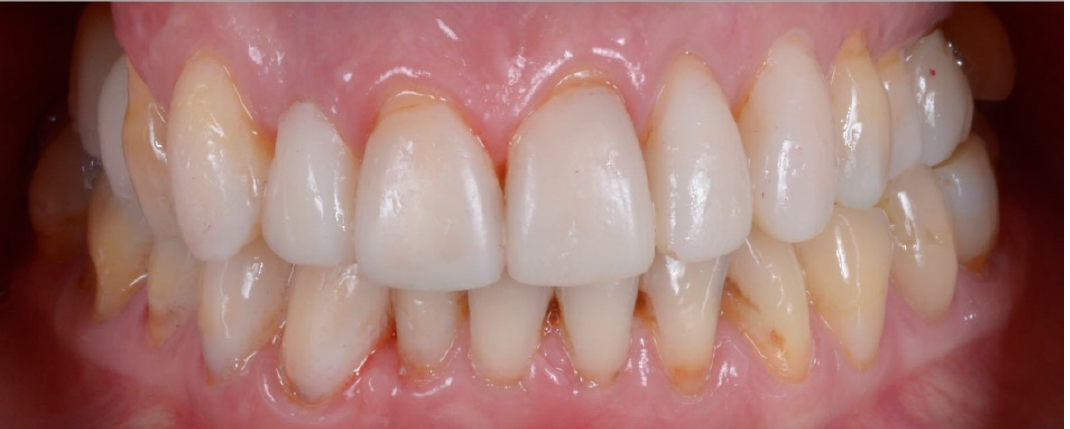
Figure 7. Initial mock-up made without tooth preparation (additive approach) through the use of a self-curing composite resin.